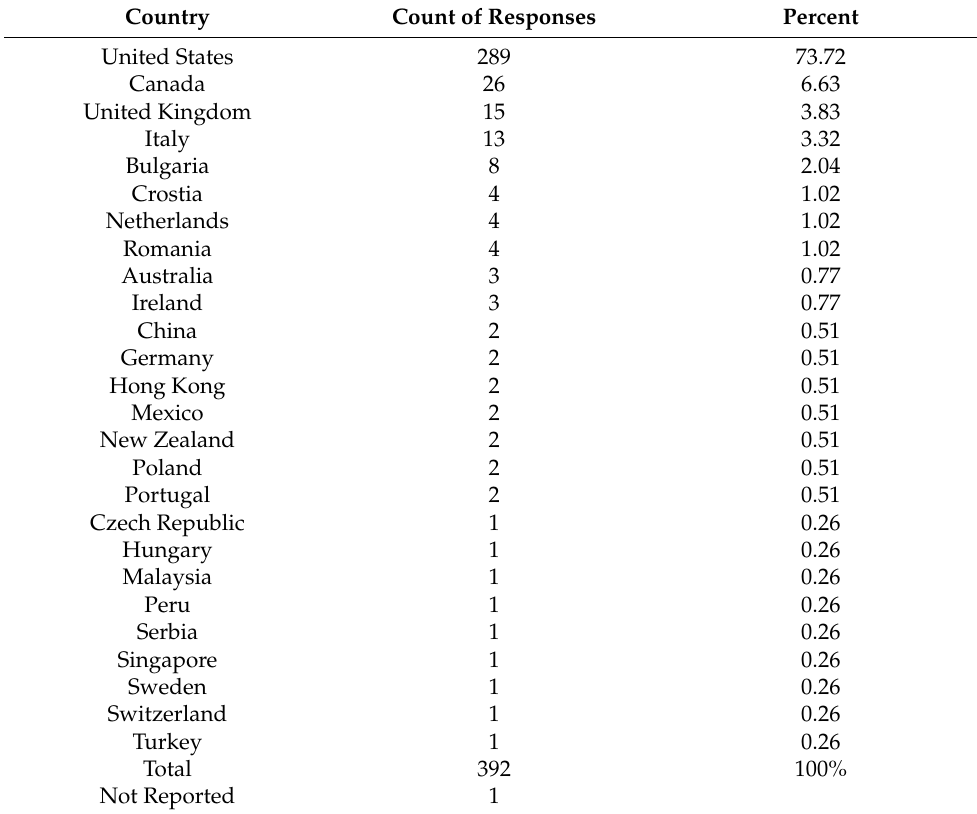
Table 1. Country of origin of survey respondents.